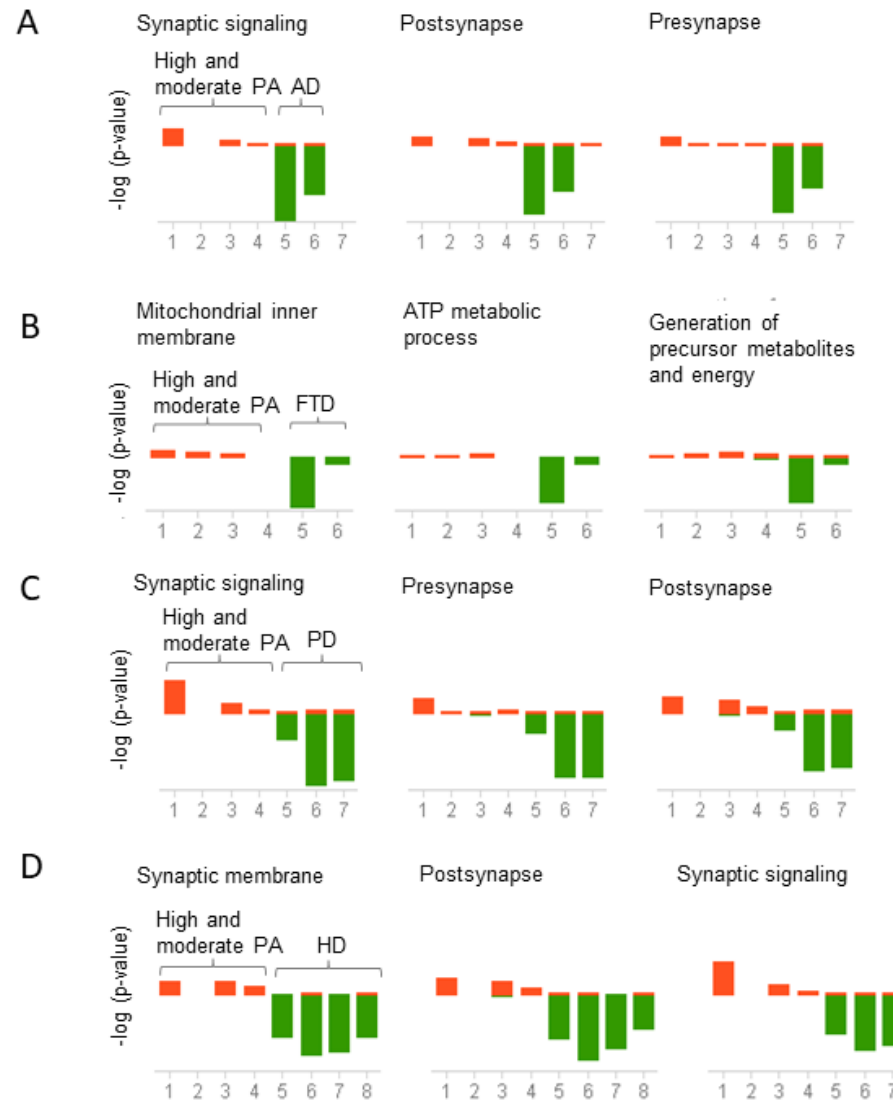
Figure 5. Correlation analysis of pathways shared between physical activity and neurodegenerative diseases. Genes upregulated in physical activity (PA) and downregulated in neurodegenerative diseases were analyzed using the meta-analysis and correlation in BSCE. The analysis was performed for each neurodegenerative disease separately. Gene ontology (GO) association terms were used for functional analysis. GO groups were filtered using a minimum size of 10 genes and a maximum of 500 genes per group. Each correlated biogroup has an associated score matrix. The height of each vertical bar represents the score of the correlation between the queried dataset and the biogroup (GO group). The orange bar above the midline represents the overlap, or enrichment, between the dataset and the upregulated genes in the dataset. Likewise, the green bar below the midline represents the overlap, or enrichment, between the dataset and the downregulated genes in the dataset. The absence of a colored bar means that the correlation is insignificant. The datasets analyzed are represented on the x-axis. High and moderate physical activity datasets (1–4) compared to ( A ) Alzheimer’s disease (AD) datasets (5–7), ( B ) Frontotemporal dementia (FTD) datasets (5–6), ( C ) Parkinson’s disease (PD) datasets (5–7), ( D ) Huntington’s disease (HD) datasets (5 = HD grade 1, 6 = HD grade 2, 7 = HD grade 3, 8 = HD grade